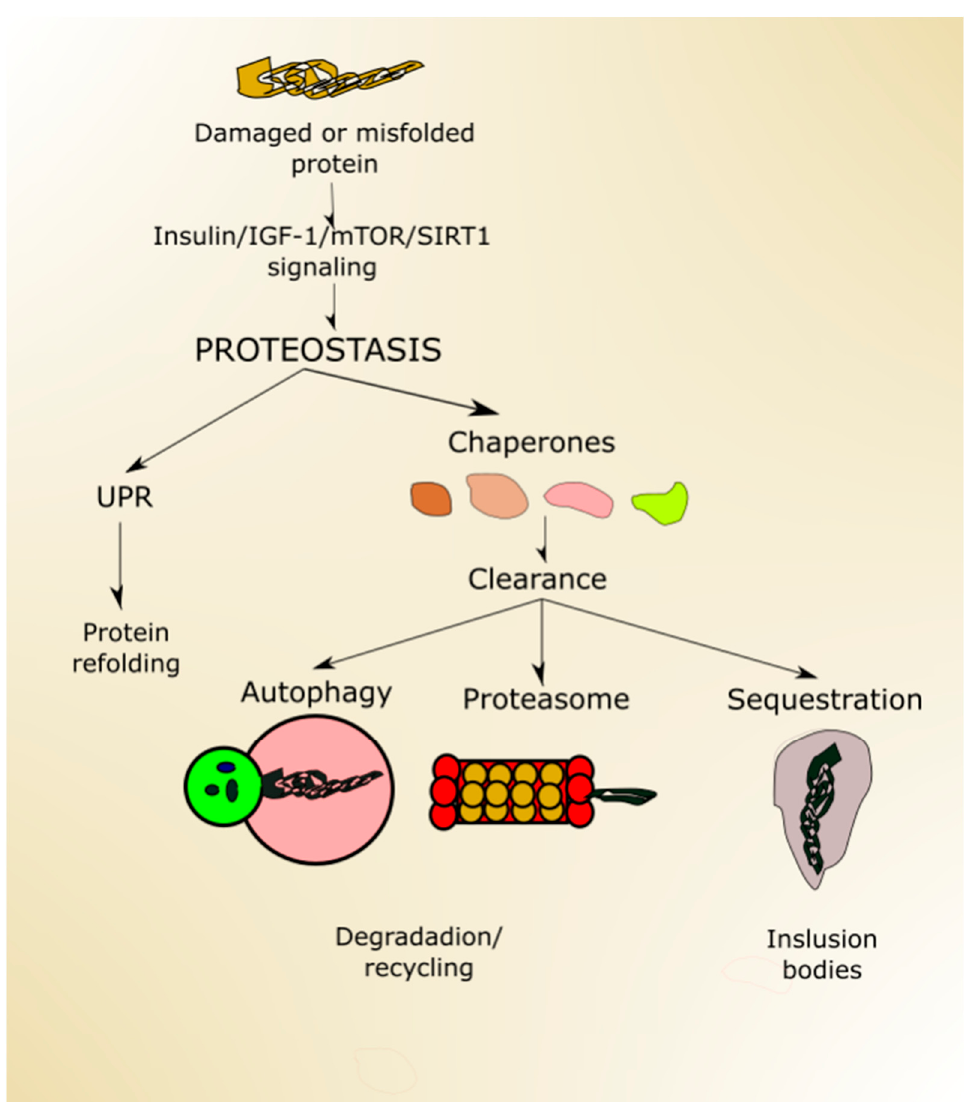
Figure 4. Proteostasis ensures protein homeostasis and is regulated by proteins and signaling pathways playing a role in aging, including (insulin ‐ like growth factor 1 (insulin/IGF ‐ 1), mechanistic target of rapamycin (mTOR) and sirtuin 1 (SIRT1). Unfolded or misfolded proteins can be targeted by unfolded protein response (UPR), and damaged proteins can be designated to degradation in the proteasome or autophagy or sequestered in inclusion bodies. All these processes may be assisted by chaperones.